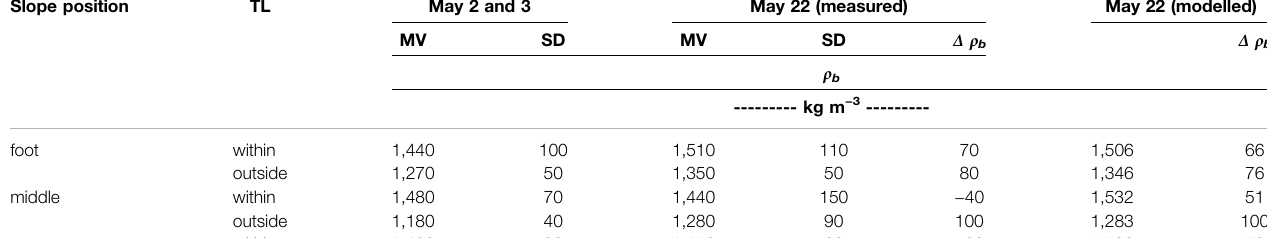
TABLE2| Surfacesoil(1 – 6 cmdepth)bulkdensity, ρ b (kgm − 3 ),fortheSfM-plotsatthethreeslopepositionsdeterminedfromsamplestakeninsideandoutsideofthewheel trackofatractorlane(TL)onMay2and3andonMay22,anddifferencesbetweenthetwotimes, Δ (forstatisticalsigni fi cantdifferencesseeboxplotsin Supplementary Appendix SA2 ); mean values (MV) and standard deviation (SD) from 3 replicates. TL, Tractor lane. Slope position